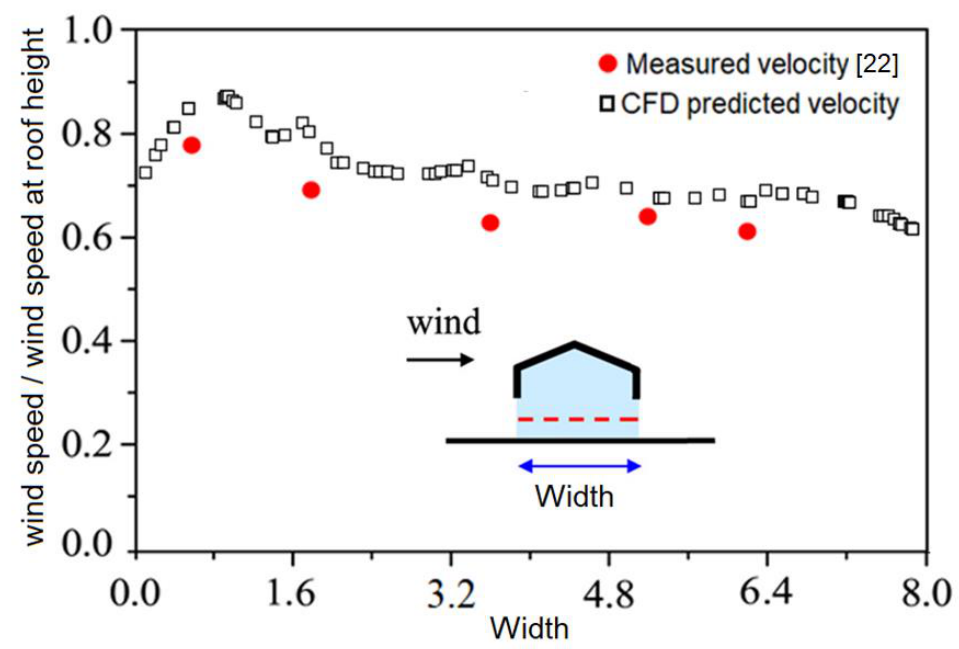
Figure 8. Comparison between measurement [22] and Computational Fluid Dynamics (CFD) prediction of streamwise air velocity along the centreline of the greenhouse openings.